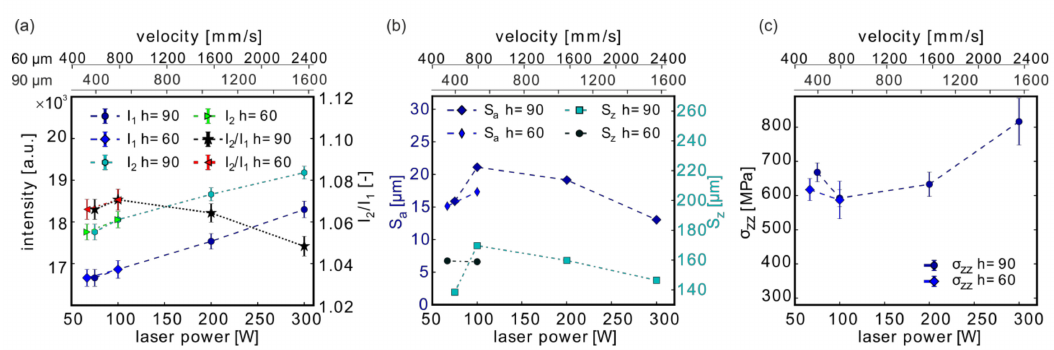
Figure 11. E ff ects of the laser power, scanning velocity, and hatch distance at constant volume energy density (E v = const.) on the MPM data ( a ), on the surface roughness ( b ), and on the residual stresses ( c ). Depicted are the results of the samples listed in Table 5. The upper-velocity axis at the top of each Figure corresponds to the h = 60 µ m and the lower one to the h = 90 µ m curves. Note: The lines connecting the measurement points are only provided as a guide for the eye.